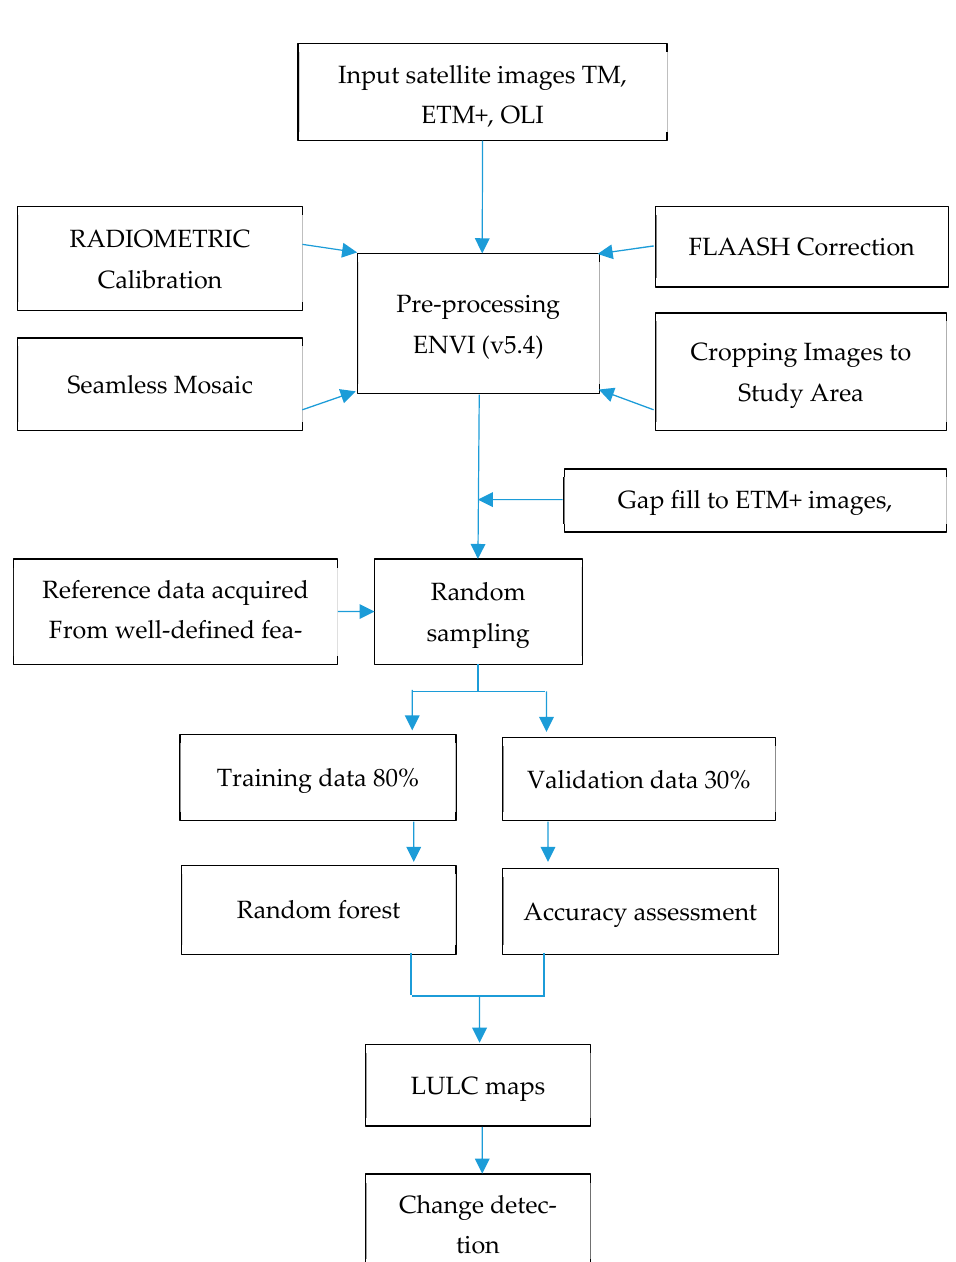
Figure 2. The methodology flow chart for the study to outline the classification and change detection steps.